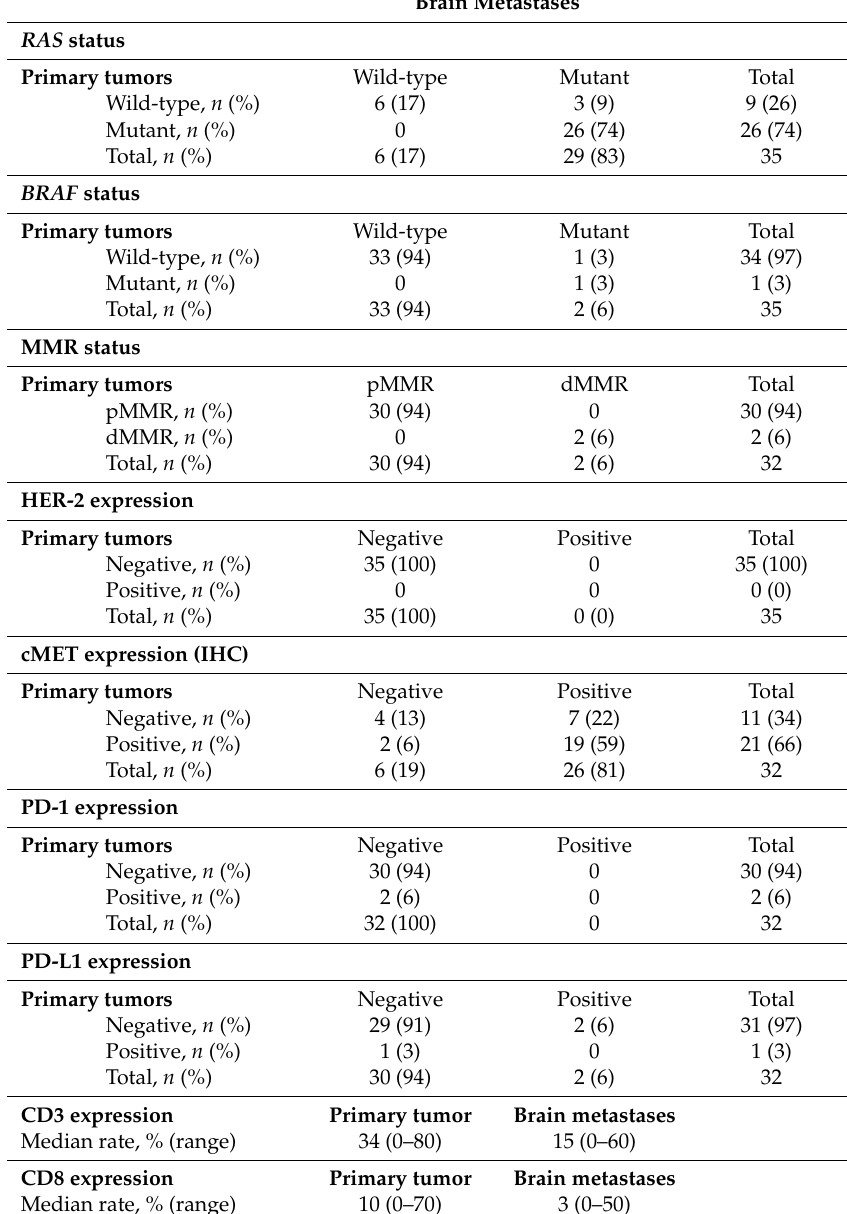
Table 3. Molecular and pathological profiles of brain metastases and paired primary